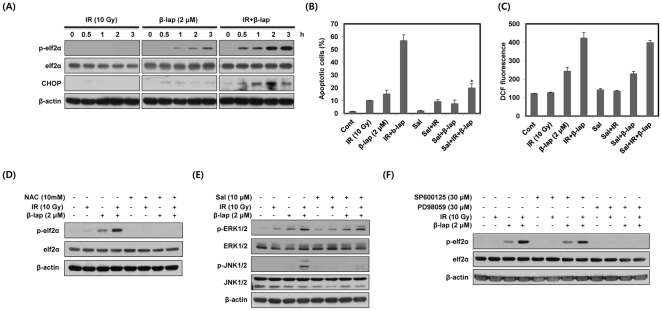
The induction of ER stress by combined treatment with IR and β-lap is required for JNK activation.(A) NQO1+-MDA-MB-231 cells were treated with IR alone, β-lap alone or combination of IR and β-lap for the indicated times. Cell lysates were subjected to Western blot analysis. The data represent a typical experiment conducted three times with similar results. (B) NQO1+-MDA-MB-231 cells were treated with IR alone, β-lap alone or combination of IR and β-lap for 24 h in the presence or absence of Sal (10 µM). After 24 h, the percentage of cells with sub-G1 DNA content was determined by flow cytometry. Results from three independent experiments are expressed as means ± SEMs. (C) NQO1+- MDA-MB-231 cells were treated with IR alone β-lap alone or combination of IR and β-lap for 3 h in the presence or absence of Sal (10 µM). After 3 h, the cells were incubated with 10 µM H2DCF-DA for 30 min and then analyzed by flow cytometry. Results from three independent experiments are expressed as means ± SEMs. (D) NQO1+-MDA-MB-231 cells were treated with IR alone, β-lap alone or combination of IR and β-lap for 30 min in the presence or absence of NAC. The data represent a typical experiment conducted three times with similar results. (E) and (F) NQO1+-MDA-MB-231 cells were treated with IR alone, β-lap alone or combination of IR and β-lap for 30 min in the presence or absence of Sal, SP600125 or PD98059. The data represent a typical experiment conducted three times with similar results.